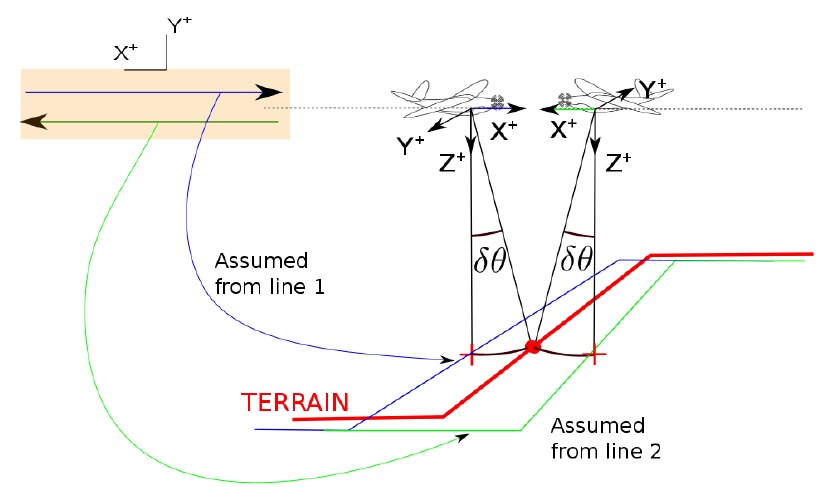
Figure 2. The blue and green slopes are subject to pitch boresight. The transformation from the blue or green profile to the real one (in red) is more complex than a single